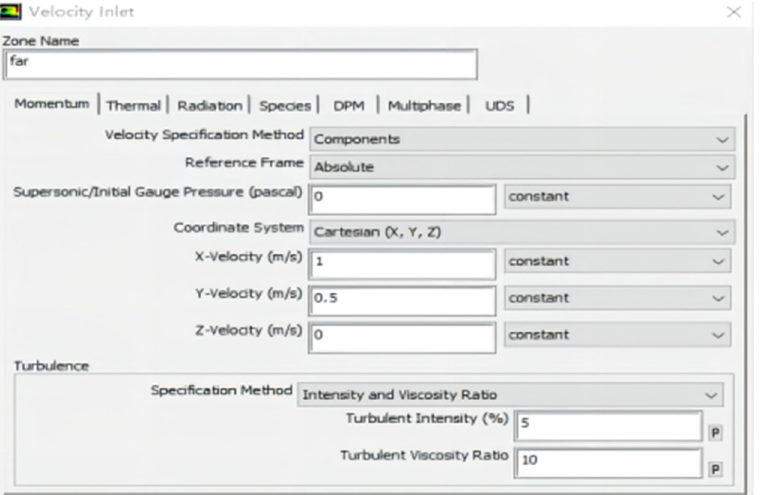
Figure 9. Settings of the boundary conditions.